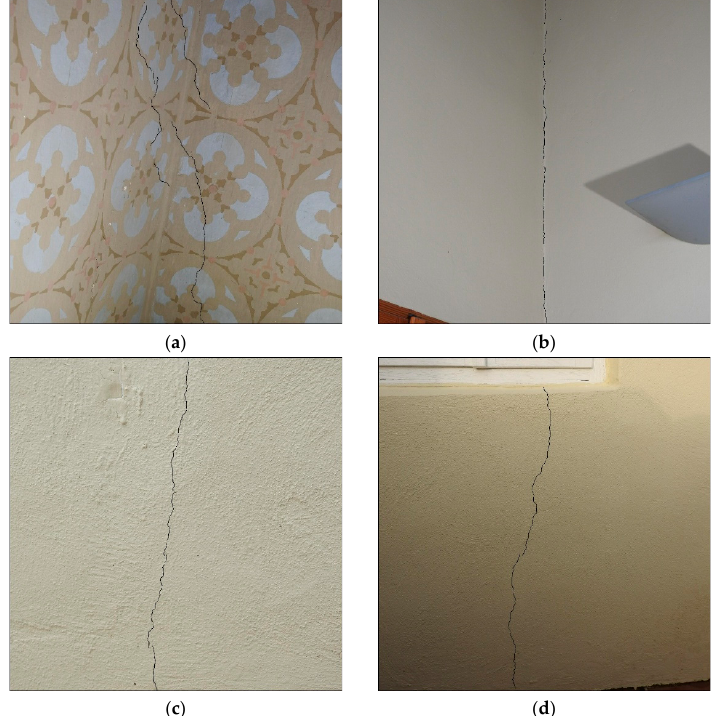
Figure 14. Typical damage observed on walls: ( a ) Oblique cracks at the junction of walls (ID 43 in Figure 10c); ( b ) Vertical crack at the junction of walls (ID 39 in Figure 10c); ( c ) Vertical crack on a façade wall (ID 8a in Figure 10a); ( d ) Vertical crack under window on a façade wall (ID 8b in Figure 10a).